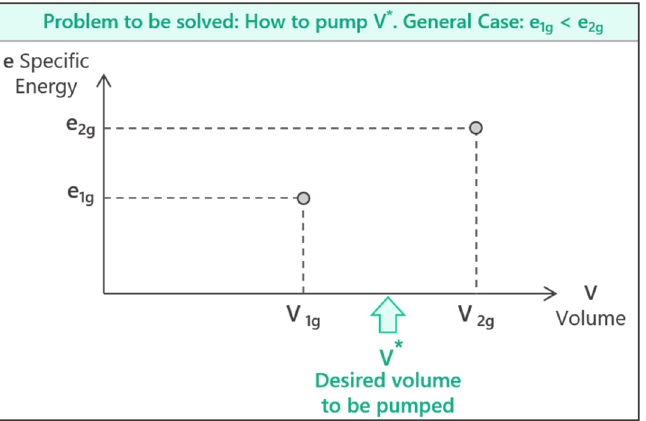
Figure 3. Problem to be solved: how many groups should be activated to pump V* before a certain time t t . Illustration theoretical example with V 1g < V* < V 2g .